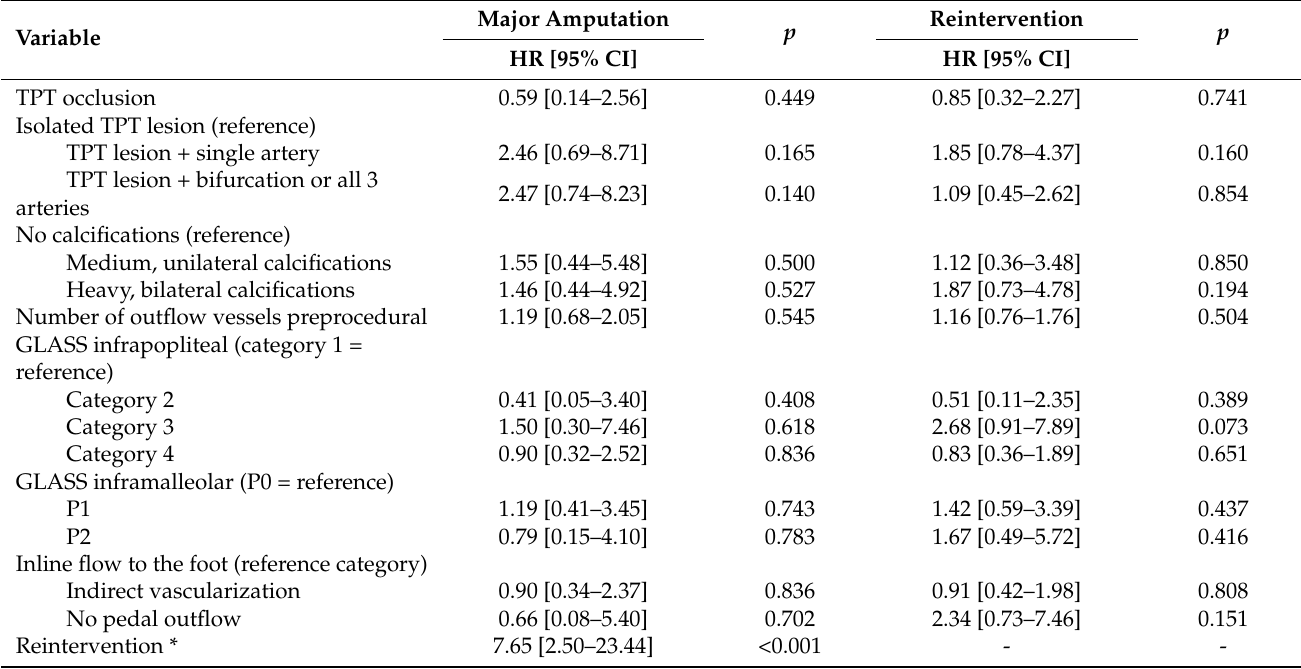
Table 4. Unadjusted hazard ratios for major amputation and